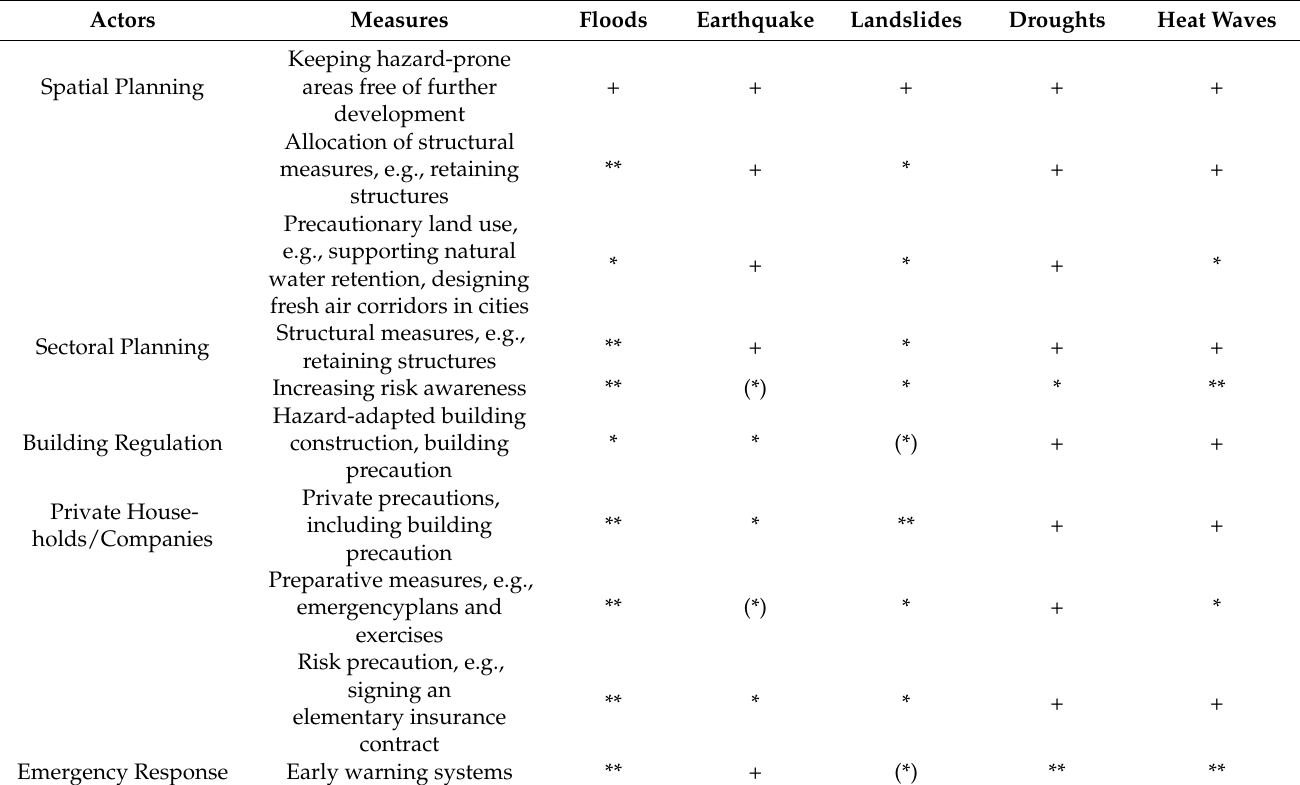
Table 3. Indication of relevant risk management measures for floods, earthquakes, landslides, droughts, storms, and extreme temperatures in